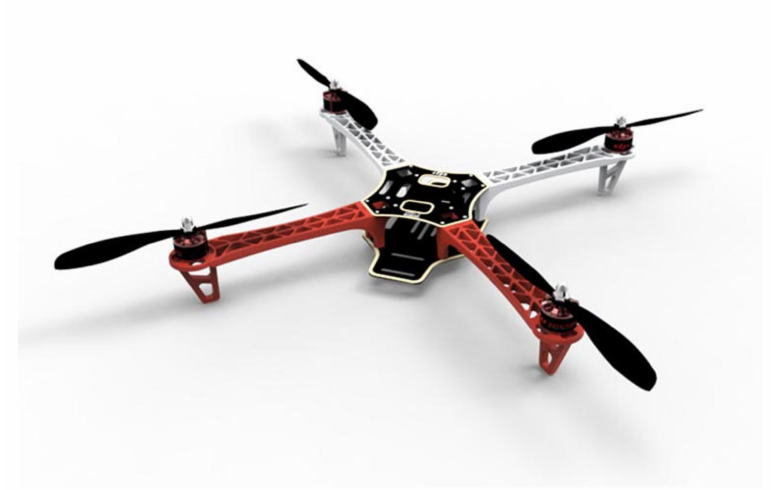
Figure 1. Picture of a commercial quadcopter platform